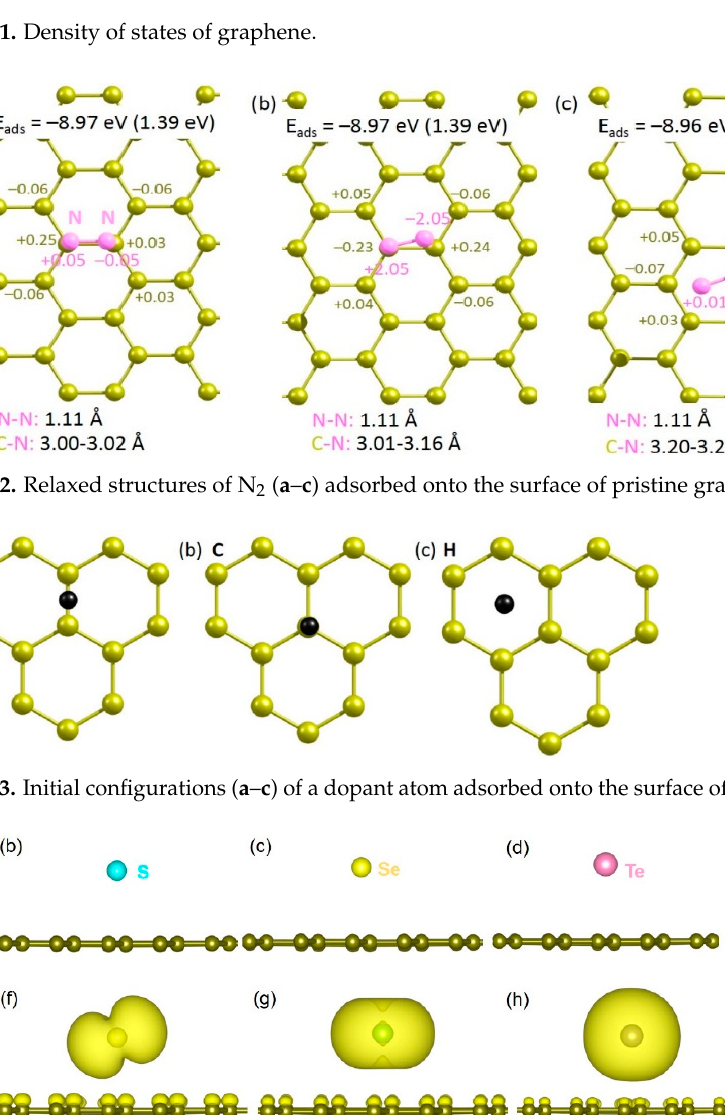
Figure 4. Relaxed structures of ( a ) O, ( b ) S, ( c ) Se and ( d ) Te adsorbed onto the graphene. Corre-